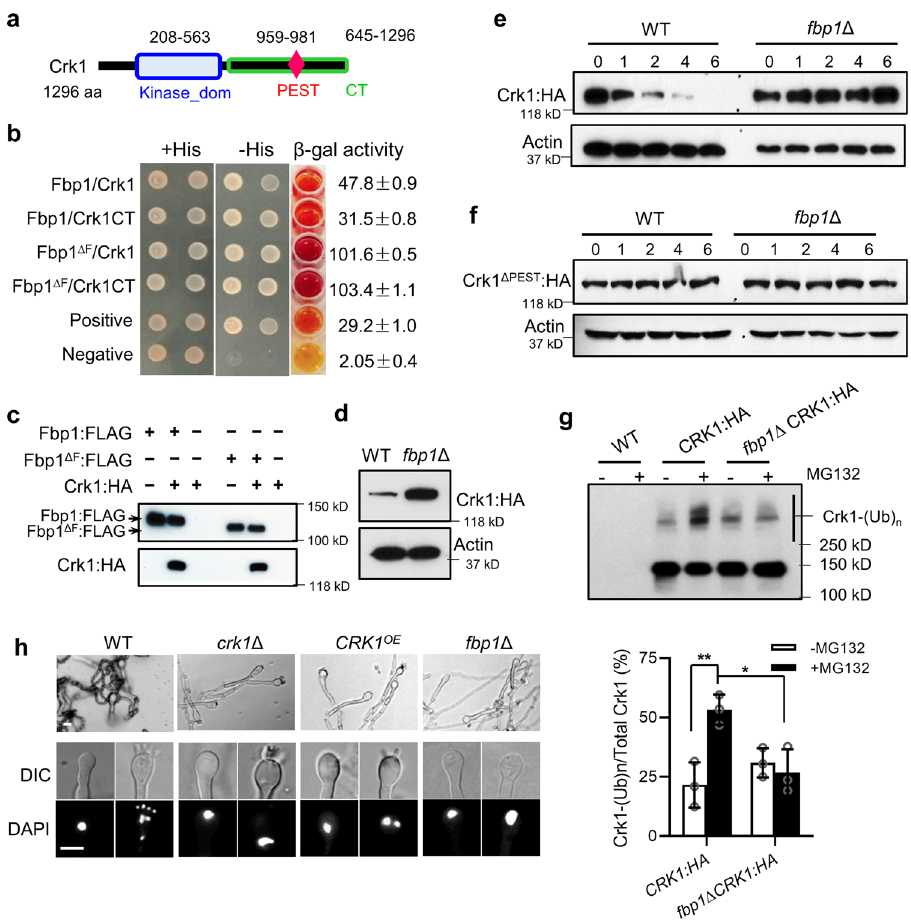
Fig.2|Crk1isasubstrateofFbp1requiredformeiosis.a Aschematicillustration of Crk1 proteins in C. neoformans . aa amino acids, Kinase_dom protein